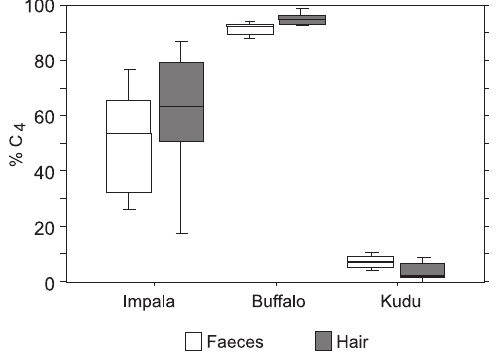
Fig. 1. Boxplot with the median 25-75 % and standard deviation of the dietary percentage of C 4 grass con- sumed by impala, buffalo, and kudu in Kruger National Park. Buffalo eat nearly 100 % C 4 grass, kudu eat near- ly 100 % browse, and impala clearly eat both. Note the strong similarity between the hair and faeces data.